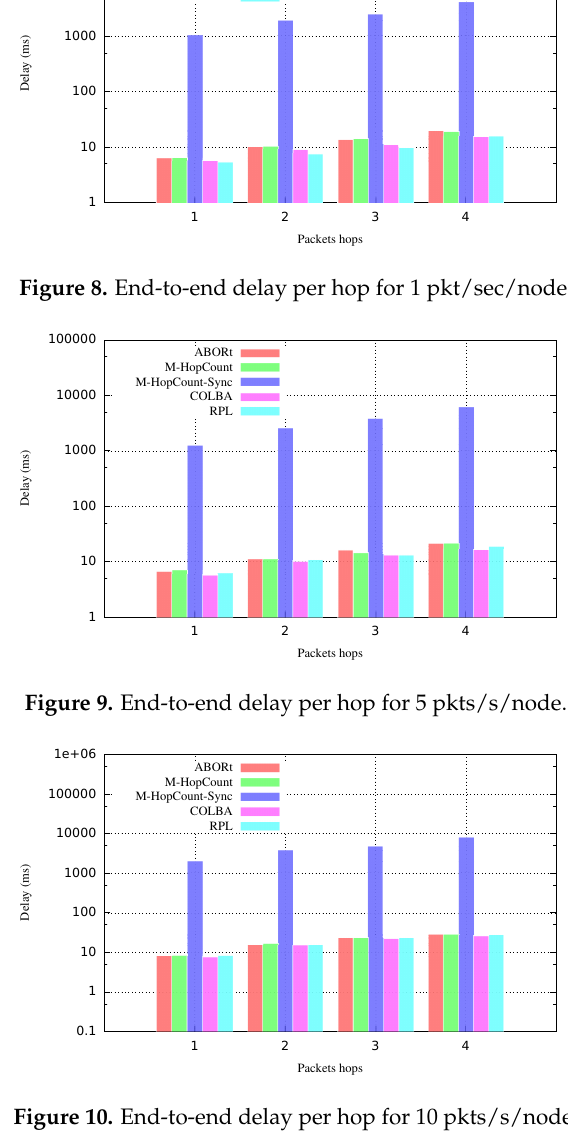
Figure 10. End-to-end delay per hop for 10